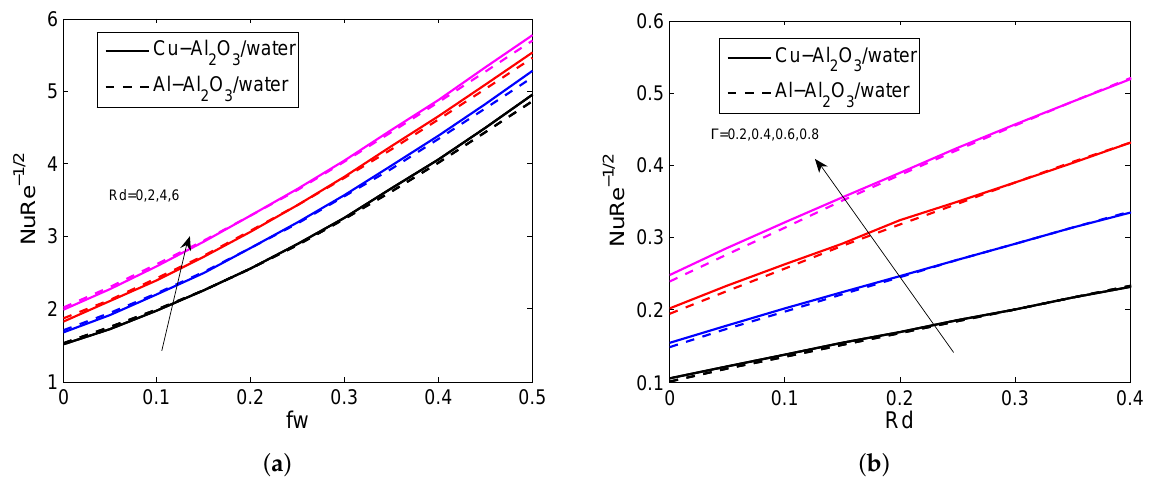
Figure 5. The impact of fw , Rd and Γ on LNN for both HNFs. Figure 6a–d shows the destructing percentage of SFC for a distinct quantity of M , Fr , f w and λ . In the case of magnetic effect ( M ) , the maximum destructing percentage of SFC is Cu − Al 2 O 3 (8.01%), Al − Al 2 O 3 (7.84%) and viscous fluid (7.72%) attains when M changes from 0 to 0.3 and the minimum destructing percentage of SFC is Cu − Al 2 O 3 (3.91%), Al − Al 2 O 3 (3.80%) and viscous fluid (3.81%) attains when M change from 0.7 to 0.9. In the case of the suction parameter ( f w ) , the maximum destructing percentage of SFC is Cu − Al 2 O 3 (16.82%), Al − Al 2 O 3 (13.38%) and viscous fluid (16.02%) attains when f w changes from 0 to 0.5 and minimum destructing percentage of SFC is Cu − Al 2 O 3 (14.59%), Al − Al 2 O 3 (12.23%) and viscous fluid (14.08%) attains when f w changes from 1.5 to 2. In the case of Forchheimer number Fr , the maximum destructing percentage of SFC is Cu − Al 2 O 3 (5.58%), Al − Al 2 O 3 (5.56%) and viscous fluid (5.64%) attains when Fr changes from 0 to 0.4 and minimum destructing percentage of SFC is Cu − Al 2 O 3 (2.15%), Al − Al 2 O 3 (2.15%) and viscous fluid (2.18%) attains when Fr changes from 1.2 and 1.6. In the case of the porosity parameter ( λ ), the maximum destructing percentage of SFC is Cu − Al 2 O 3 (1.92%), Al − Al 2 O 3 (2.91%) and viscous fluid (2.14%) attains when modi- fies λ from 0.2 to 0.3 and minimal destructing percentage of SFC is Cu − Al 2 O 3 (1.70%), Al − Al 2 O 3 (2.45%) and viscous fluid (1.88%) attains when modifies Γ from 0.5 to 0.6.